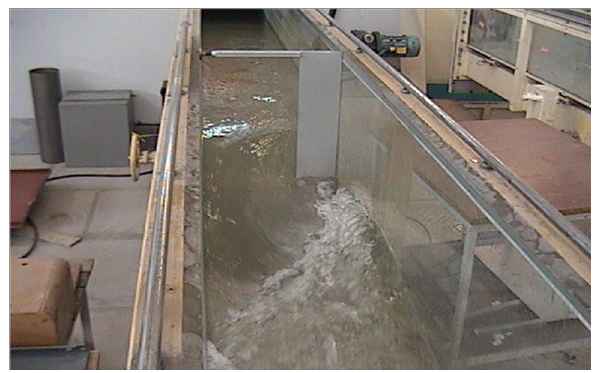
Fig. 9 The shock pattern in the first reflection of downstream of bar-